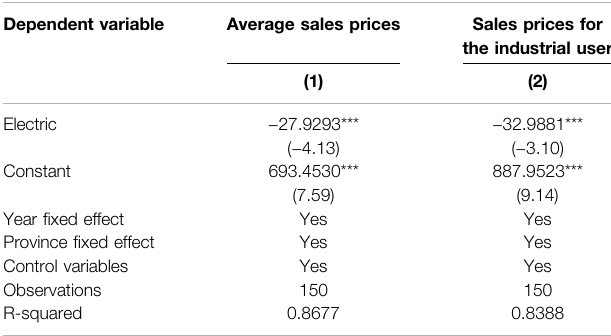
TABLE 6 | Impacts of the TDPR on electricity